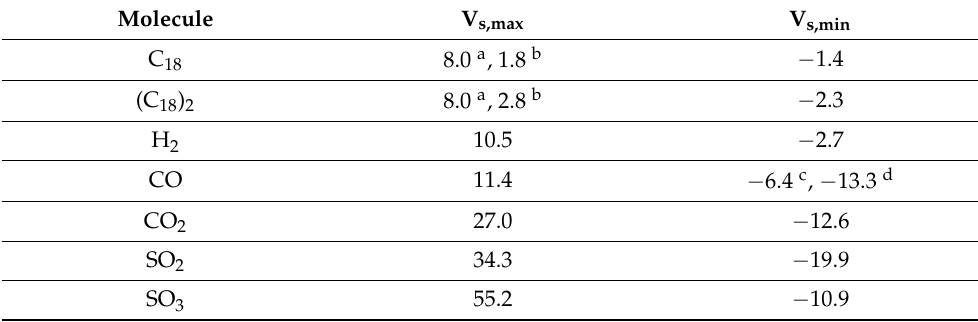
Table 4. Extrema of MEP (kcal/mol) calculated at ω B97XD/Def2TZVPP level of theory.